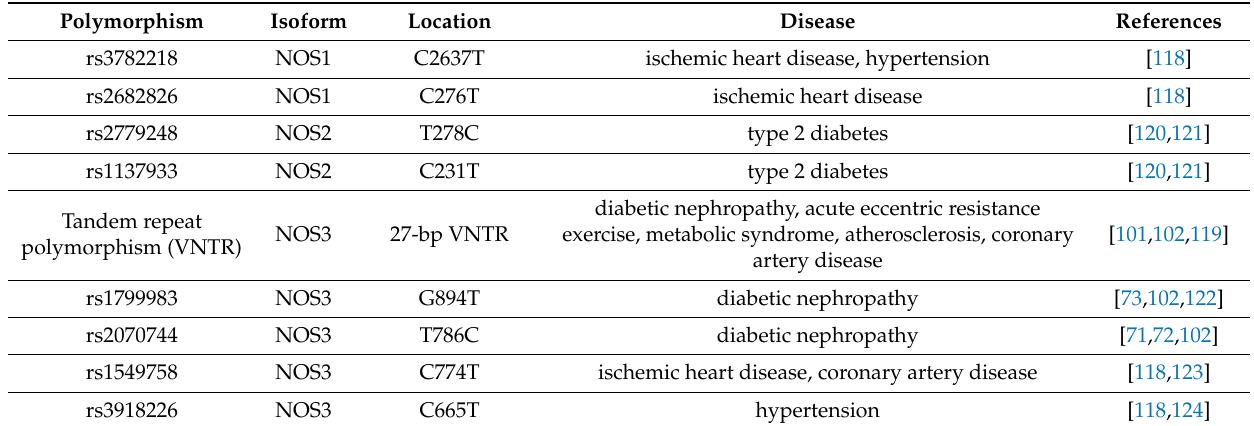
Table 2. Selected polymorphisms of NOS and their characteristics